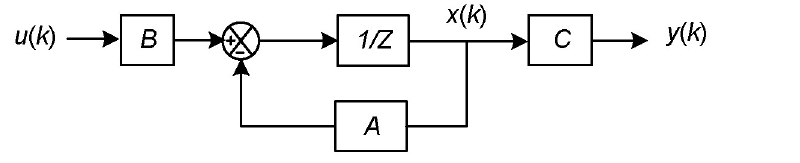
Fig 3. Block diagram of CPMC